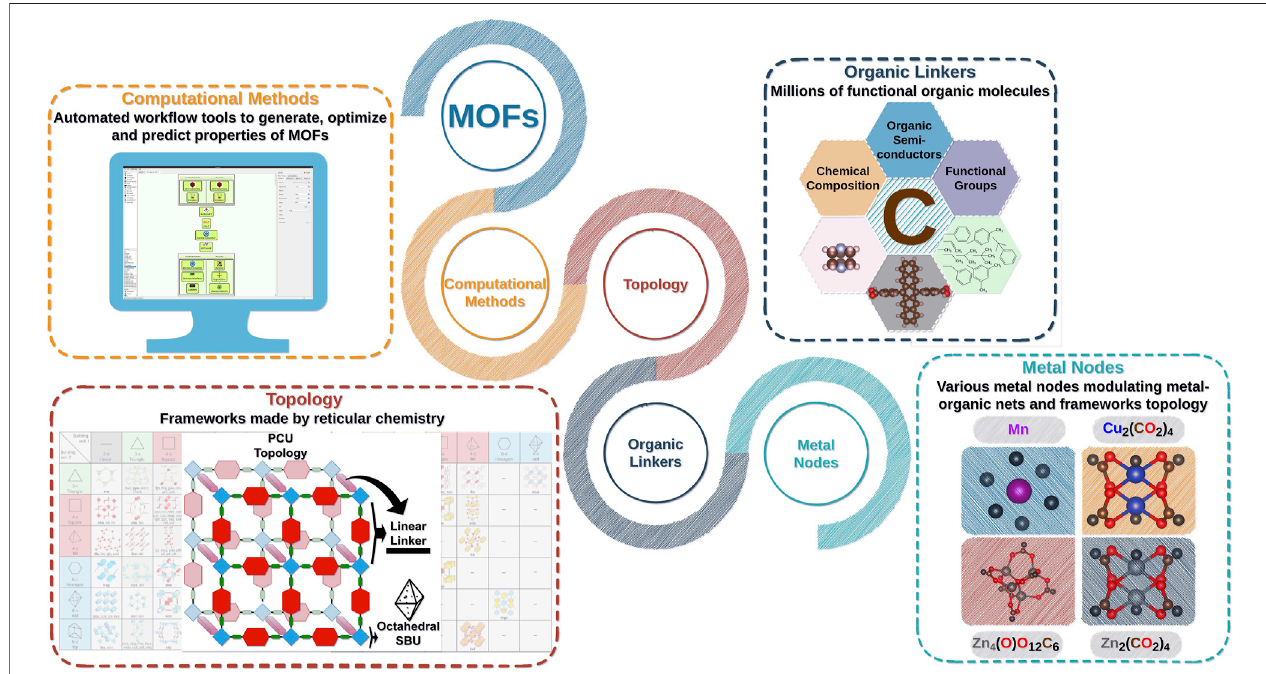
FIGURE 1 | Reticular chemistry applied for the fabrication of MOFs with diverse metal – organic networks, components (organic molecules and metal nodes), and properties. Virtual design of new MOF materials by automated work fl ows investigated in this report.